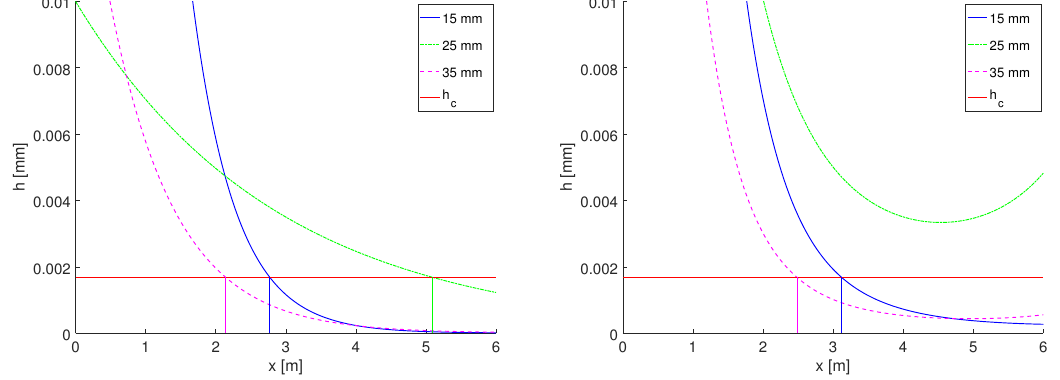
Figure 10. The course of the thickness of the oil layer in model dependencies for different pipe diameter values—15, 25 and 35 mm (critical value is h c = 1.68675 µ